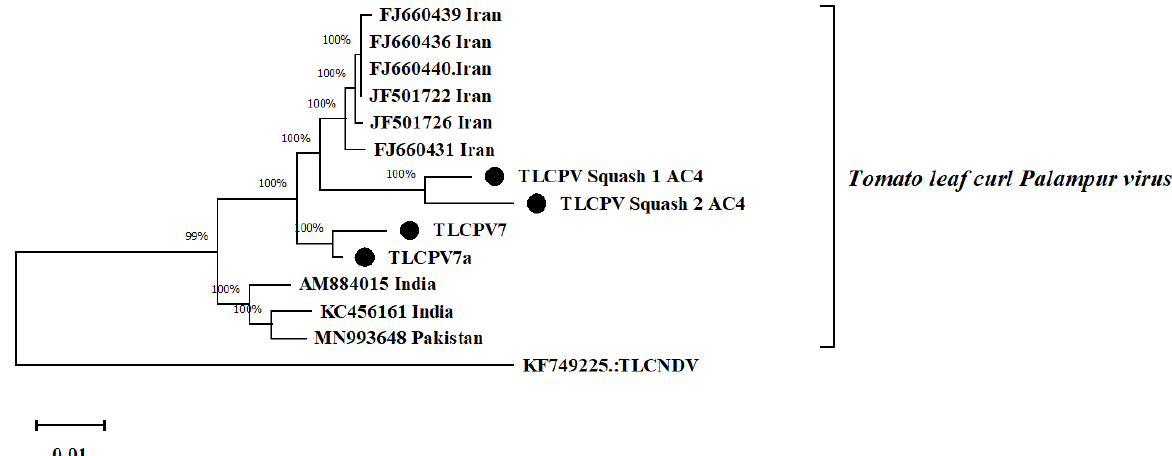
Figure 6. Neighbor joining phylogenetic tree constructed from partial begomoviral AC4 nucleotide sequences of ToLCPMV isolates from Iraq (marked with ● ) and equivalent GenBank sequences. Tomato leaf curl New Delhi virus TLCNDV was used as an out-group